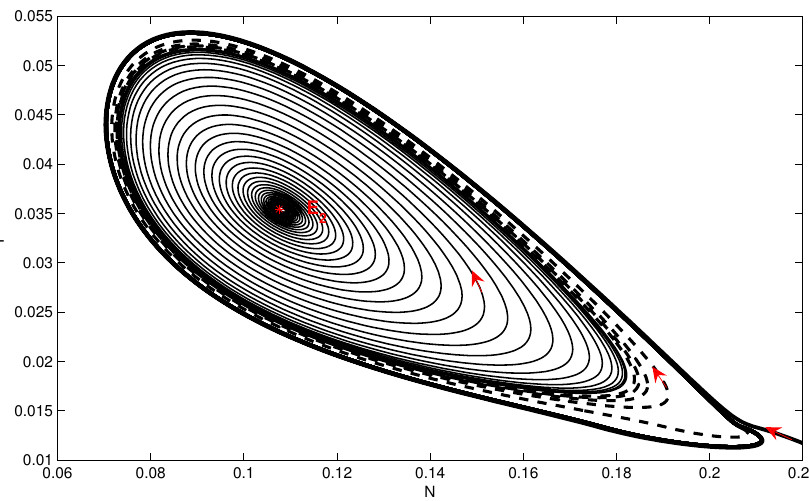
Figure 10. The phase portrait of model Equation (3) when E 1 is